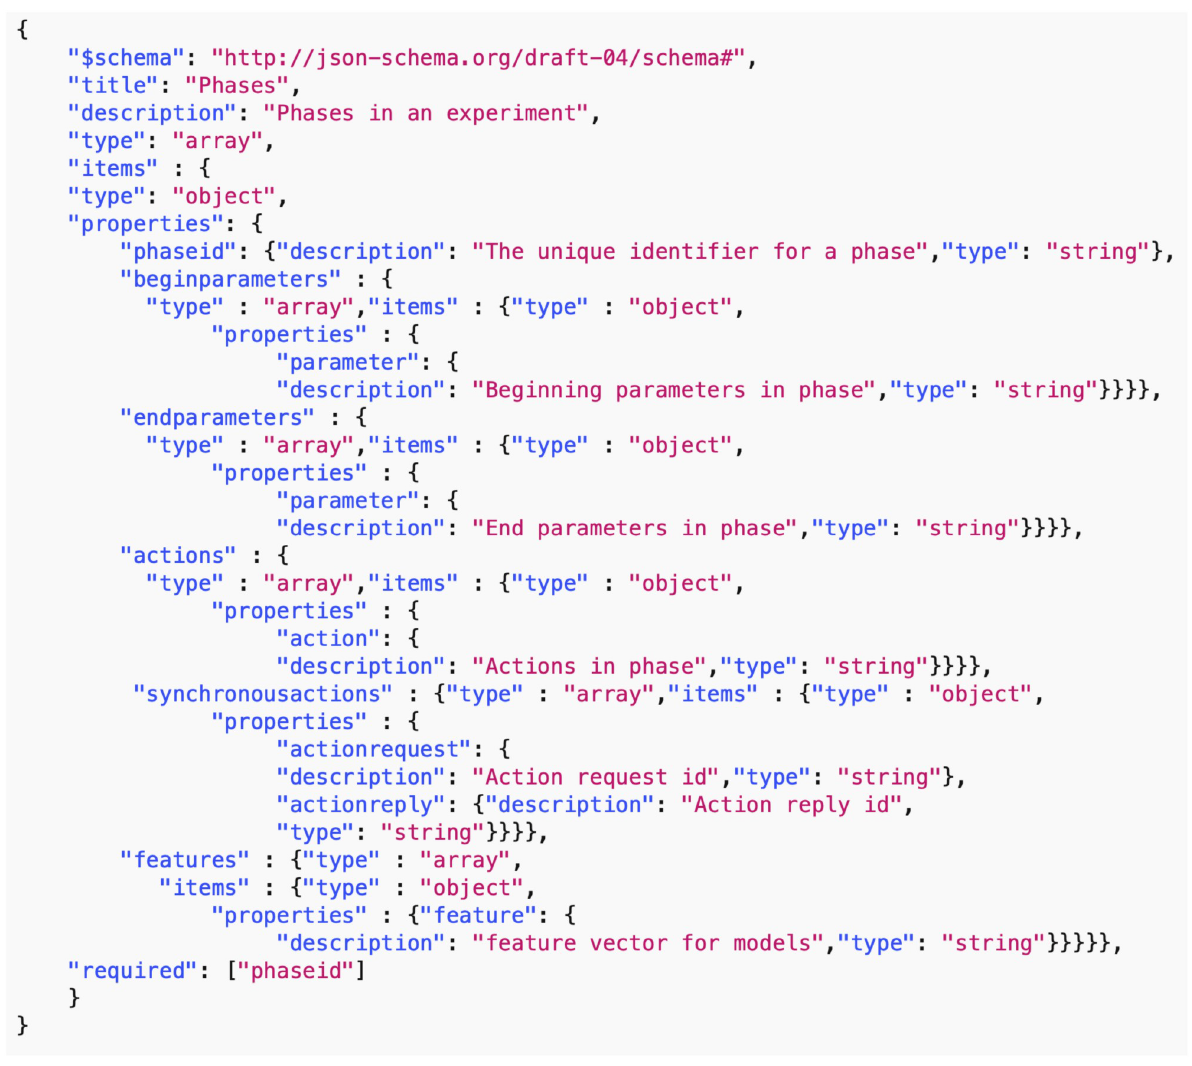
Fig 21. JSON schema for the “Phase Description” of the data common